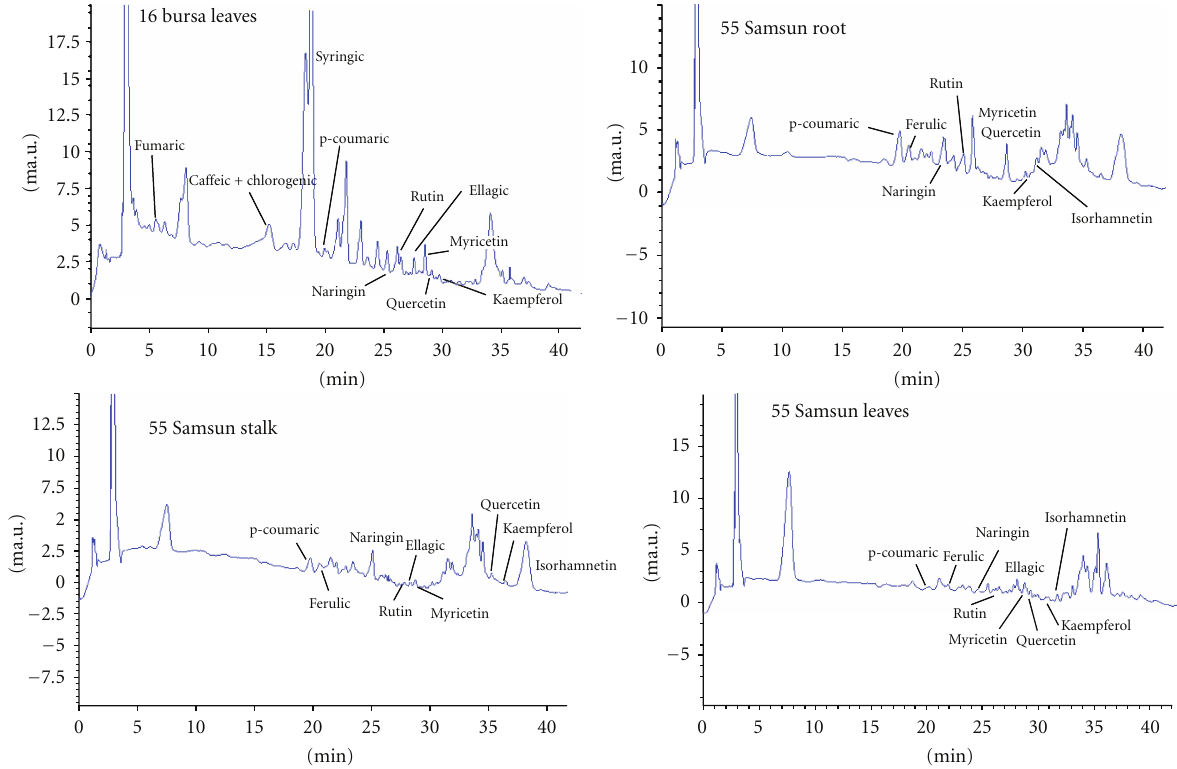
Figure 1: HPLC chromatogram of Antalya, Ayd ı n, Bursa and Samsun root, stalk and leaves sample.